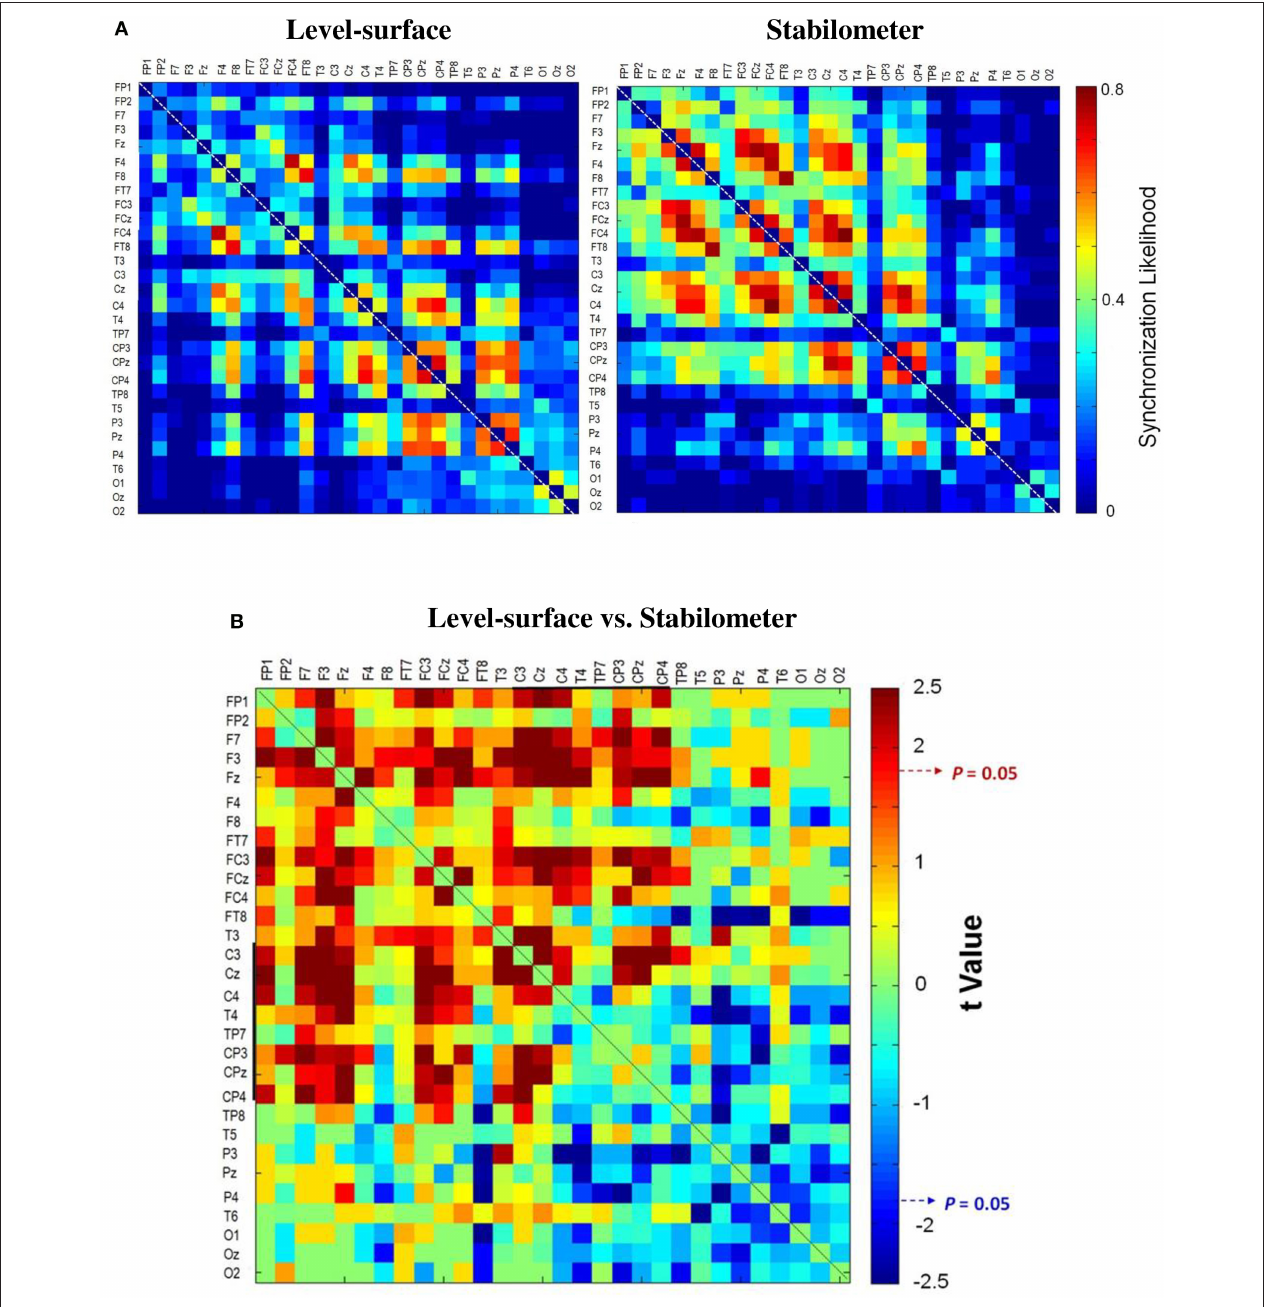
FIGURE 4 | The pooled adjacent matrix of synchronization likelihood (SL) of preparatory ERP for the concurrent force-matching and postural tasks in the level-surface and stabilometer conditions (threshold value = 0.3). (A) Population means of SL adjacent matrix in the surface (left) and stabilometer (right) conditions. (B) The adjacent matrix of t -values for contrasting SL between the level-surface and stabilometer conditions ( t > 1.771, stabilometer SL > level-surface SL, p < 0.05; t < − 1.771, level-surface SL > stabilometer SL, p < 0.05).